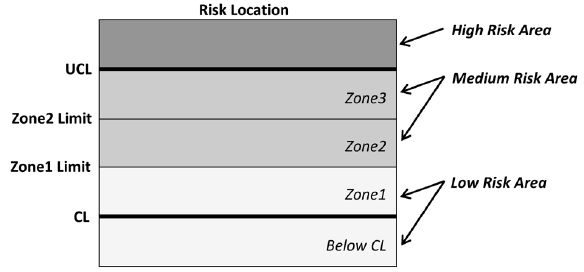
Fig. 1. Definition of statistical zones relative to the location of a workplace